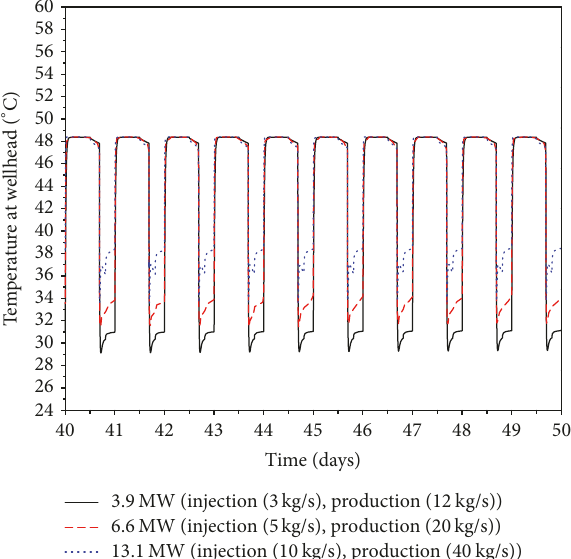
Figure 7: The energy flow rates at the wellhead in the three different cases.